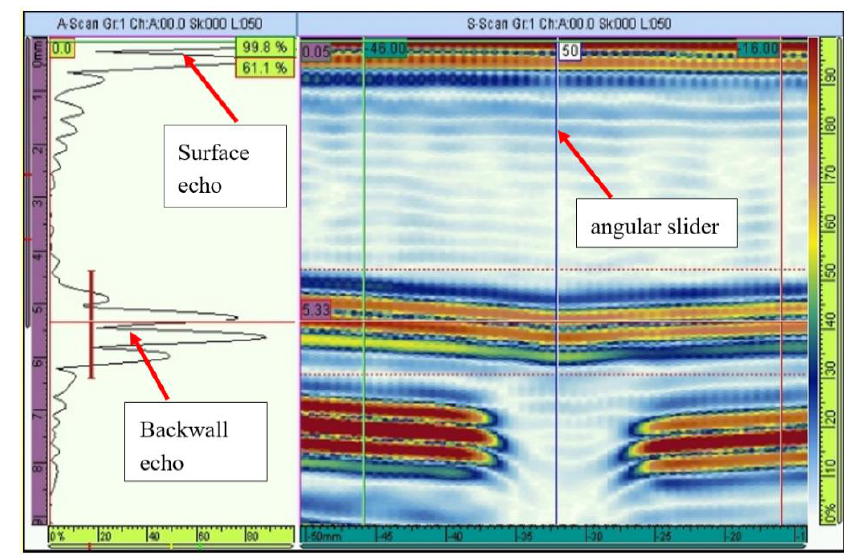
Figure 16. A-scan ( left ) and S-scan ( right ) of non-damaged zone around impact simulation cut.